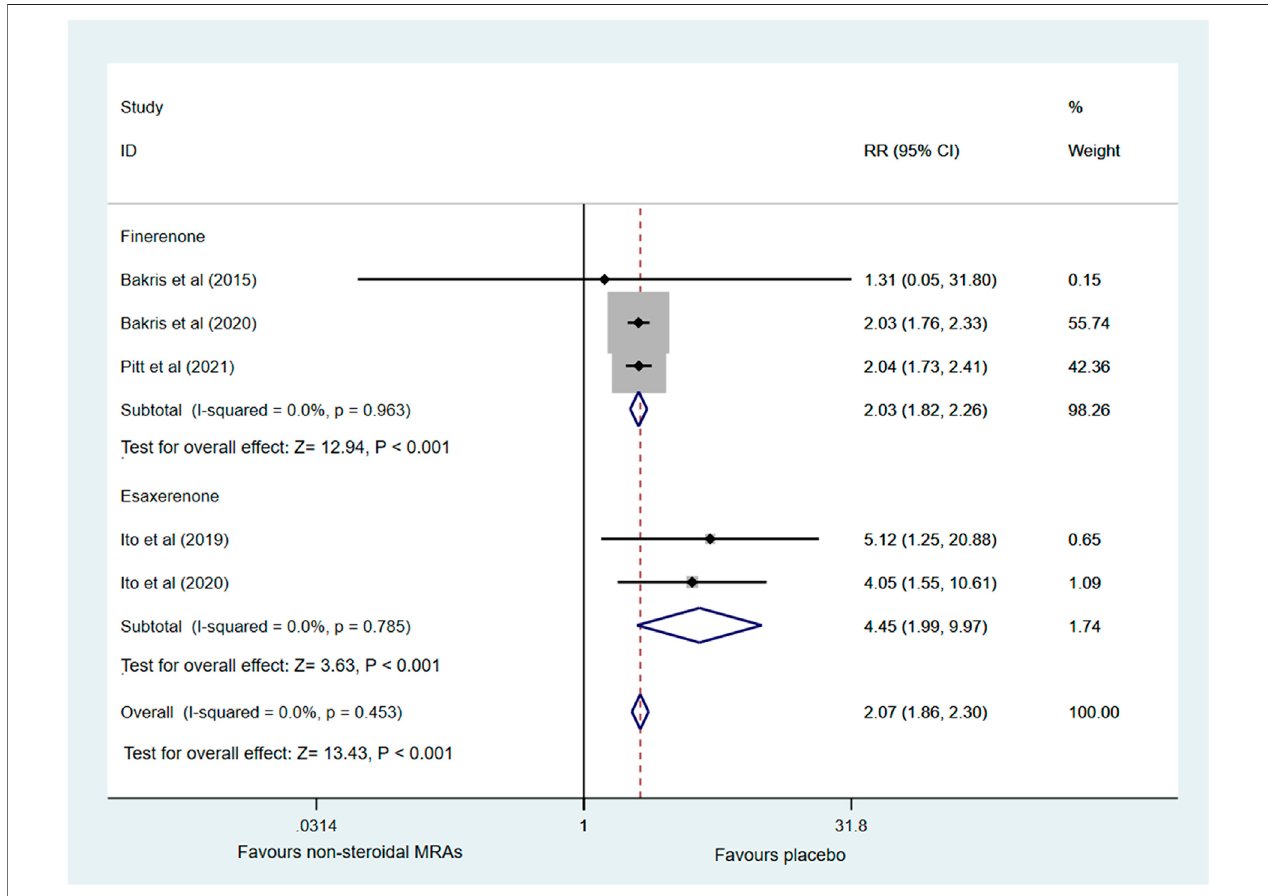
FIGURE6| Forestplotfortheeffectofnon-steroidalMRAsontheincidenceofhyperkalemiainpatientswithCKDandT2D.RR,riskratio;MRAs,mineralocorticoid receptor antagonists; CKD, chronic kidney disease; T2D, type 2 diabetes.